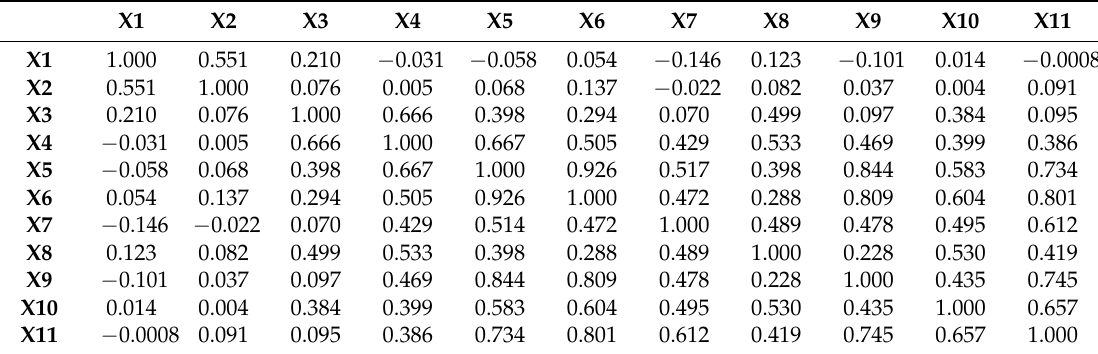
Table 3. Pearson correlation coefficients for variables related to input load.